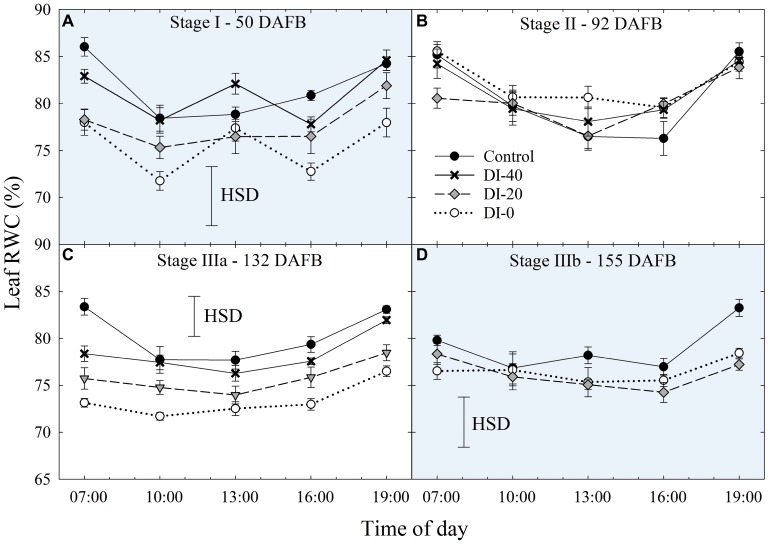
Daily curves of leaf relative water content (RWC) at stages I (A), II (B), IIIa (C), and IIIb (D) of ‘September Bright’ nectarine fruit growth. Trees irrigated to 100% (control), 40% (DI-40), 20% (DI-20), and 0% (DI-0) of crop evapotranspiration. Error bars represent standard errors of means (n = 6). Significant differences determined with analysis of variance and Tukey’s honestly significant difference (HSD, p < 0.05).